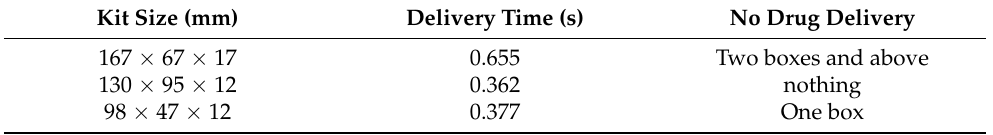
Table 3. Outgoing test results of different